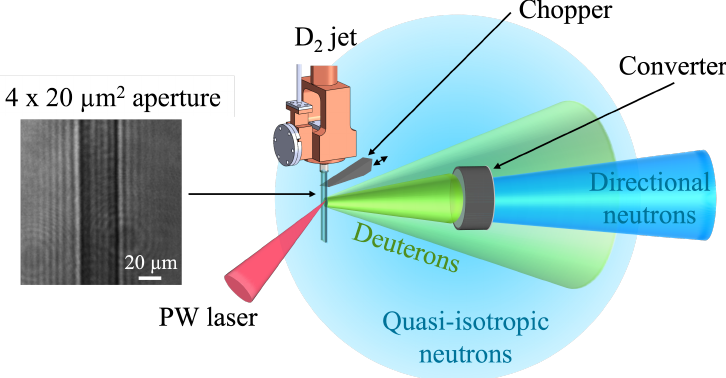
Figure 1. The platform setup consists of a petawatt laser, the cryogenic liquid D 2 jet target for deuteron acceleration, and the converter for neutron production. A shadowgraphy image of the planar cryogenic deuterium jet target is shown in the inset. The neutron beam has both a quasi- isotropic and a directional